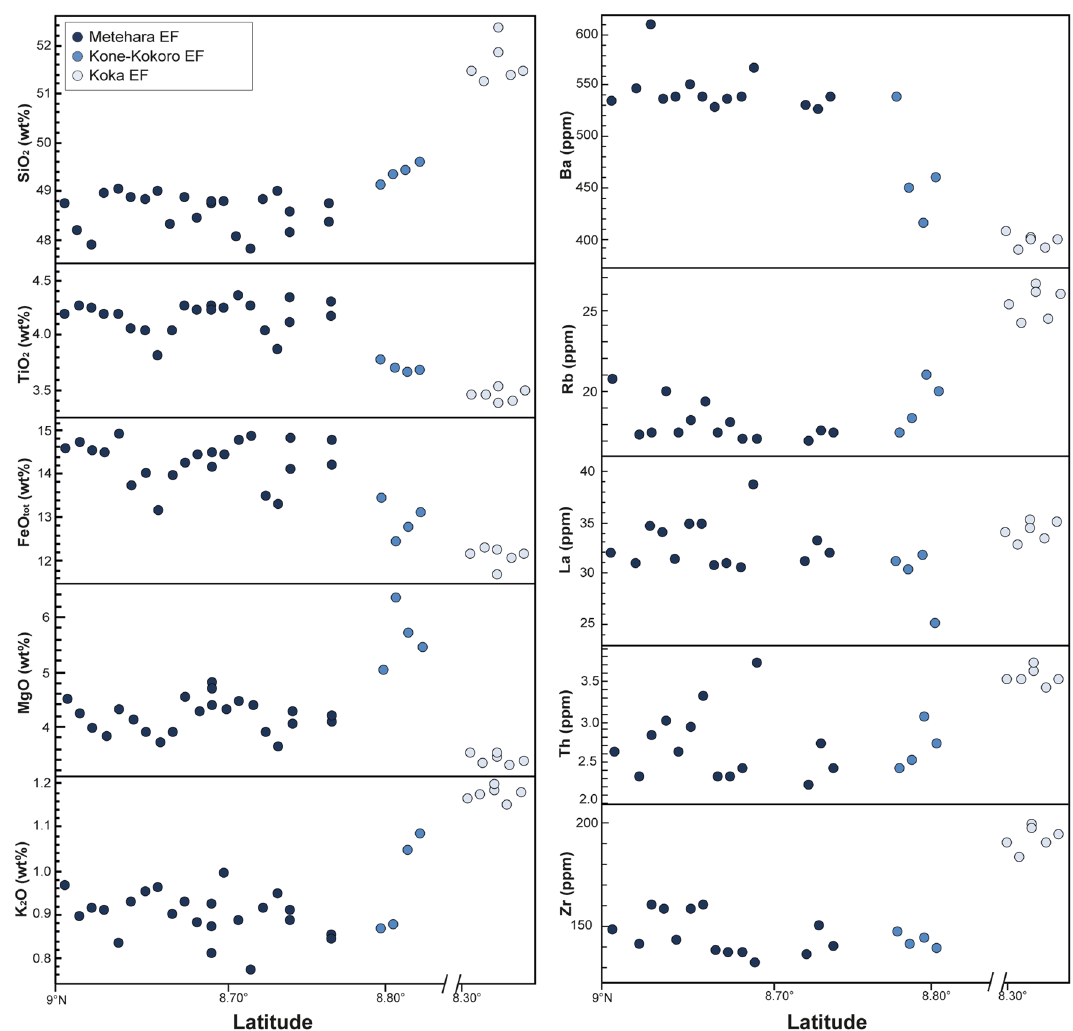
Figure 7. Latitude vs. major and trace element whole rock compositions for the eruptive fissures (EF) of Metehara, Kone-Kokoro and